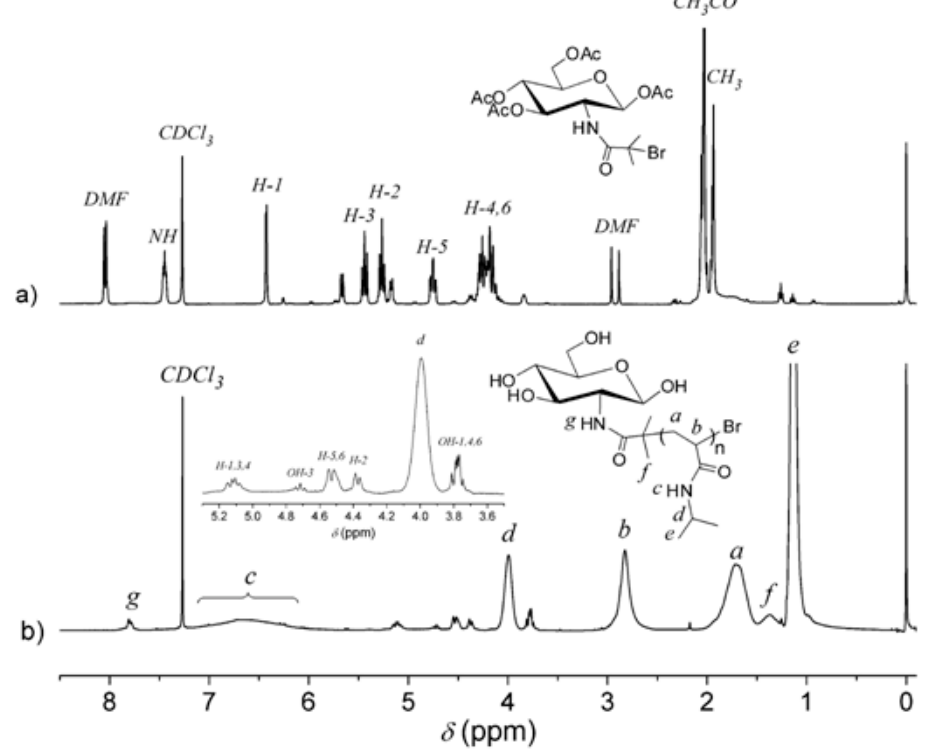
Figure 2. 1 HNMR spectra of ( a ) the GA initiator (i) and ( b ) GA-PNIPAM (i), both in CDCl 3 .